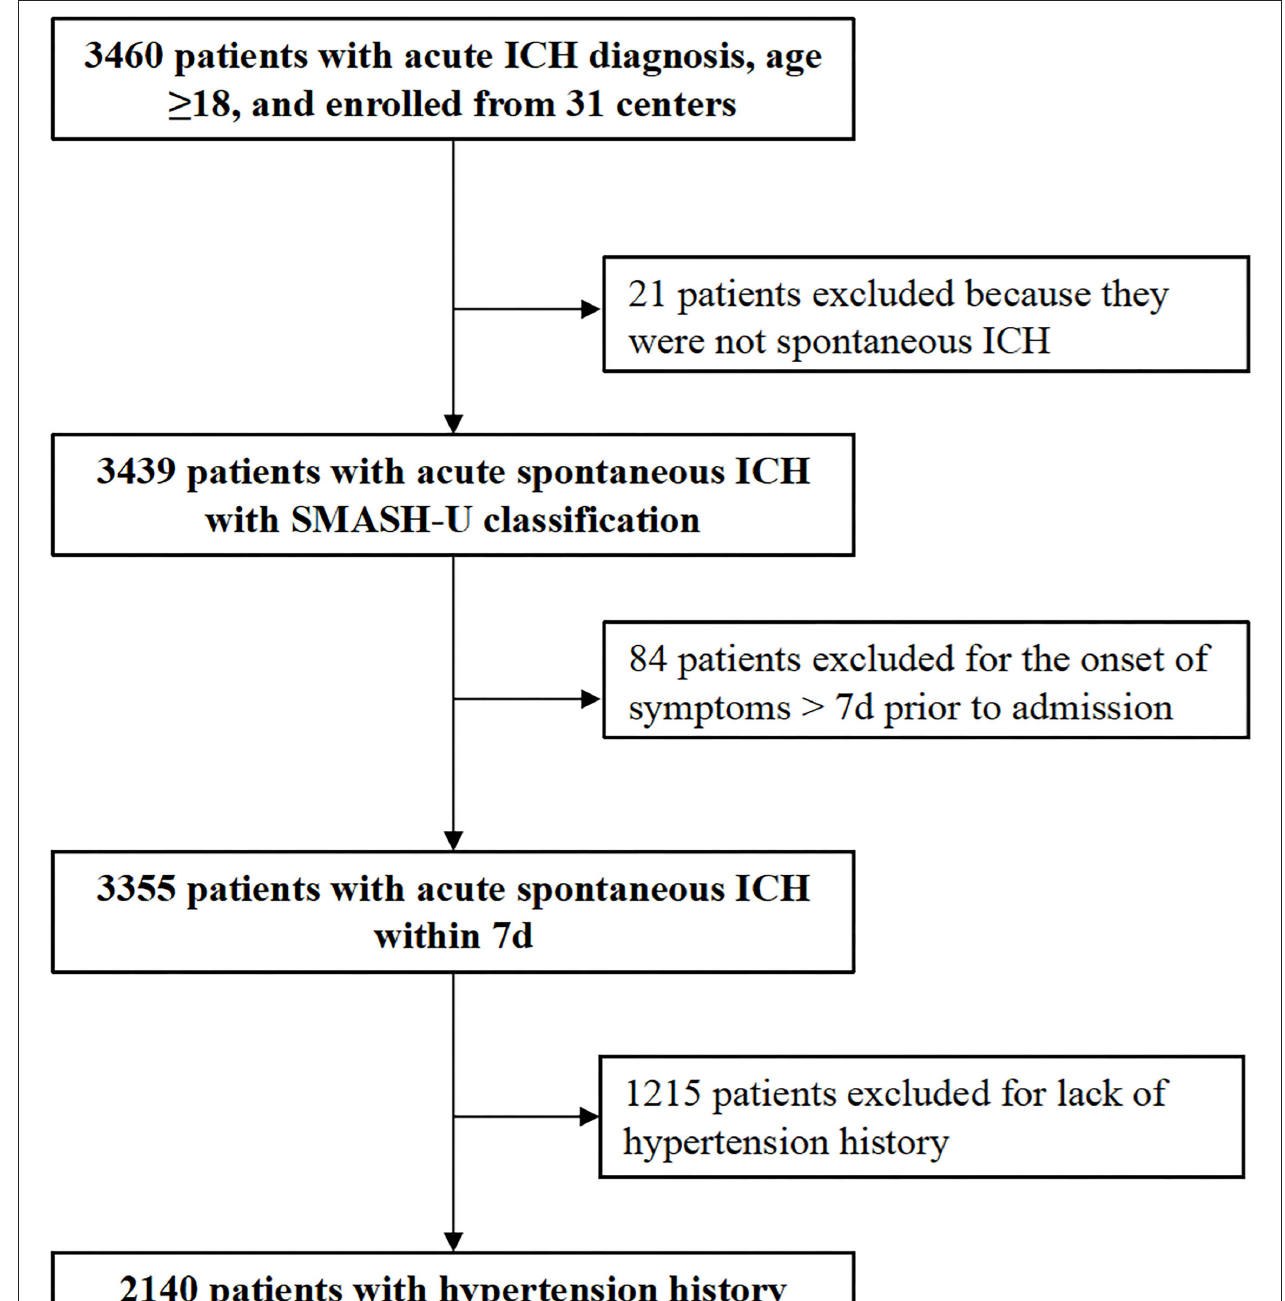
FIGURE 1 | Flowchart of patient